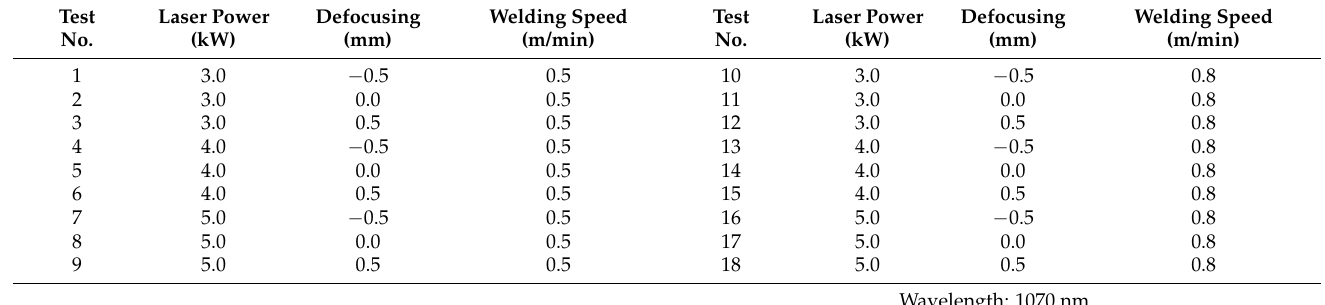
Figure 3. Schematic diagram of penetration geometry measurement. Table 3. Fiber laser welding parameters and experimental conditions.